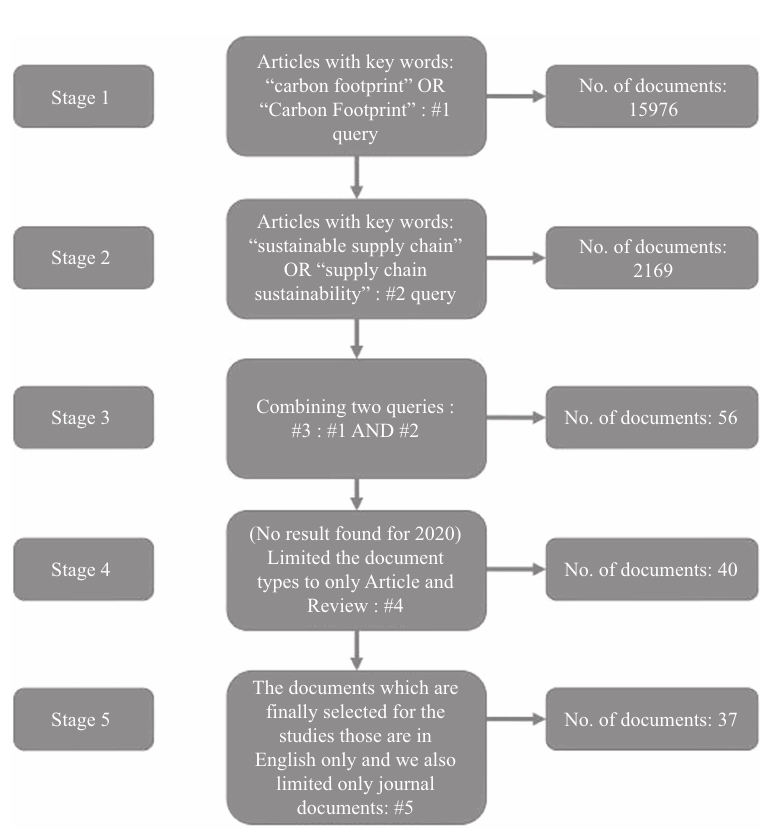
Figure 1. The stepwise search process for data